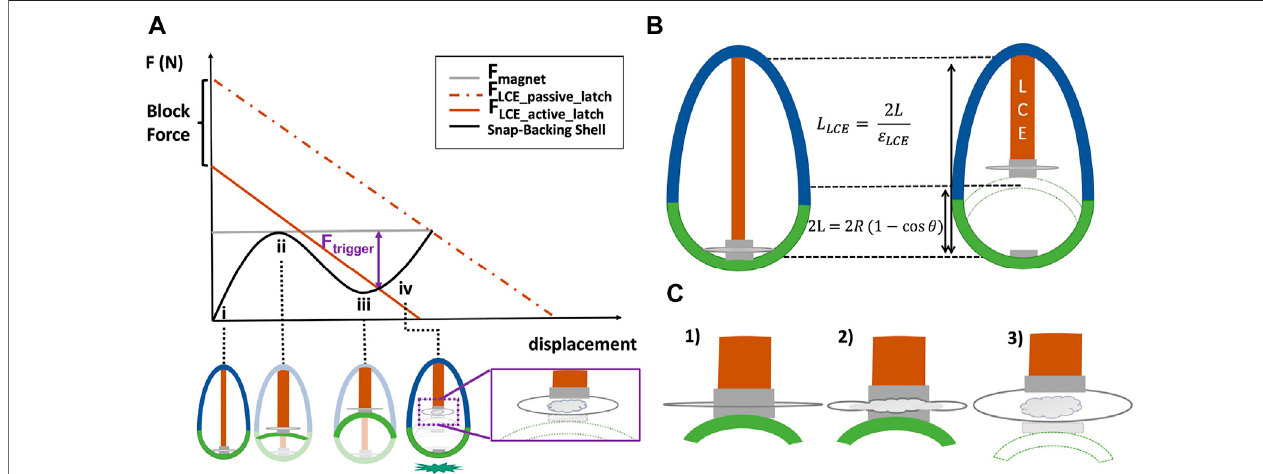
FIGURE 3| Continuously variable design parameters enable the selection of an actuator, elasticshell,and latch that can be tuned to maximize energystorage. (A) Representative force-displacement plot for the elastic shell and of the LCE muscle. (i) represents the initial con fi guration of the shell (non-inverted); (ii) its marginal inversionposition; (iii) thesnap-through(inverted)state,and (iv) triggerpointpastthesnap-throughregion. (B) Kinematicconstraintsonthetopcaplengthasafunction of the geometry of the LCE and the shell. (C) Schematic of the behavior of the active latching when triggered. From left to right, 1) the sandwiched pouch between two magnets (one connected to the LCE and the other to the shell); 2) the low-boiling point liquid starts to evaporate and in fl ate the pouch; then, 3) when the F trigger is enough to detach the two magnets (i.e., minimum gap is created), the shell is free to snap-back to the ground.